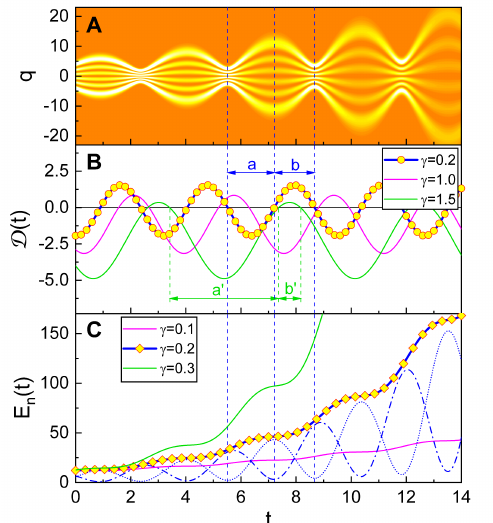
Figure 6. Contour plot of the probability density |(cid:104) q | ψ n (cid:105) GA | 2 ( A ) as a function of q and t , where we have chosen γ = 0.2; the corresponding temporal evolutions of the ratio D ( t ) ( B ) and the quantum energy E n ( t ) ( C ) for several different values of γ . a and b ( a (cid:48) and b (cid:48) ) in ( B ) are examples of time intervals of wave expansion and collapse, respectively, for γ = 0.2 ( γ = 1.5). The extra curves in ( C ), i.e., the dash-dot curve and the dotted curve are quantum electric energy T n ( t ) and the magnetic energy V n ( t ) , respectively, for the case of γ = 0.2. We have used A = B = 2, n = 5, ω 0 = 1, ¯ h = 1, (cid:101) = 1, t 0 = 0, and ϕ = 0. This figure corresponds to complicated general nonstatic waves which exhibit periodical wave collapse and expansion unified with the gradual